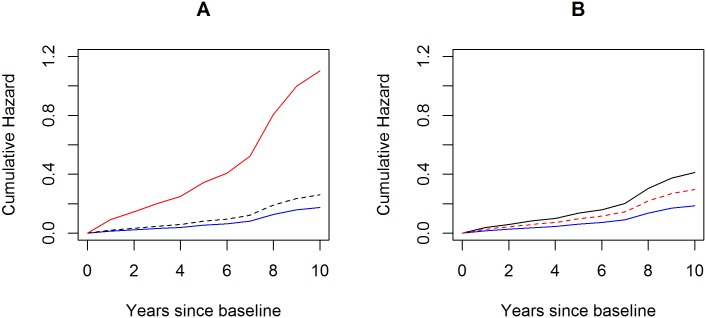
Cumulative hazards of incident AD dementia by APOE ε4 and TOMM40 ‘523-L genotypes in African Americans.The figure illustrates cumulative hazards of incident AD dementia for representative female African Americans with mean age and education. For panel A, the blue solid curve represents cumulative hazard for non-ε4 carriers, the black dash curve for ε4 heterozygotes, and the red solid curve for ε4 homozygotes. For panel B, the blue solid curve represents cumulative hazards for non-‘523-L carriers, the black solid curve for ‘523-L heterozygotes, and the red dash curve for ‘523-L homozygotes.